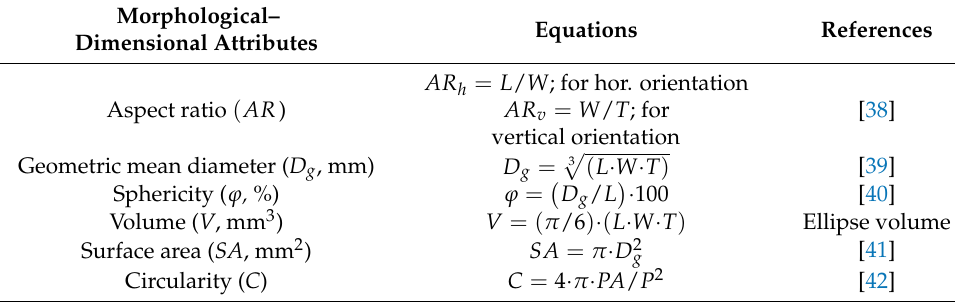
Figure 3. Size and area measurements of the grape cultivars. Table 2. Equations used for morphology and dimensional attributes of the grape